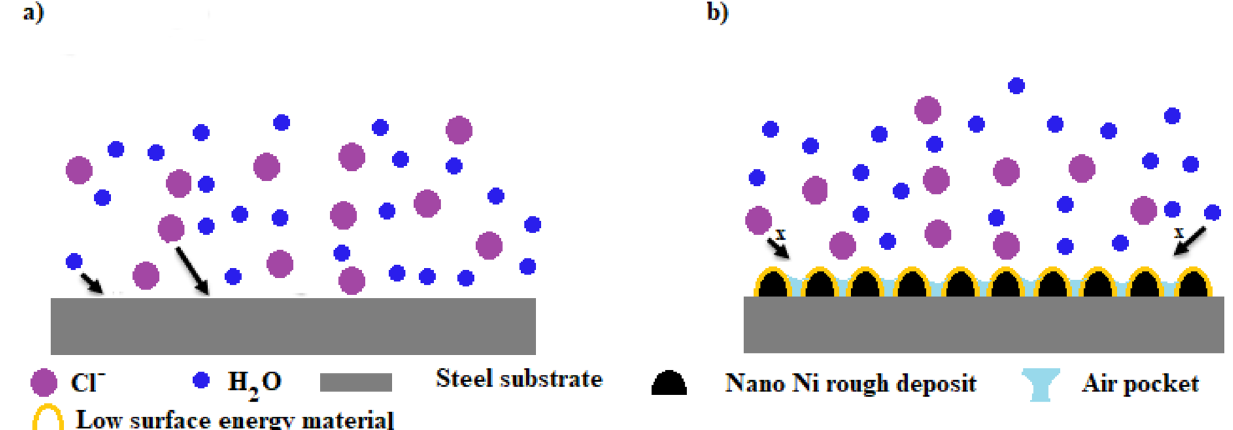
Figure 18. A diagram of the suggested mechanism for corrosion protection of the prepared SHP